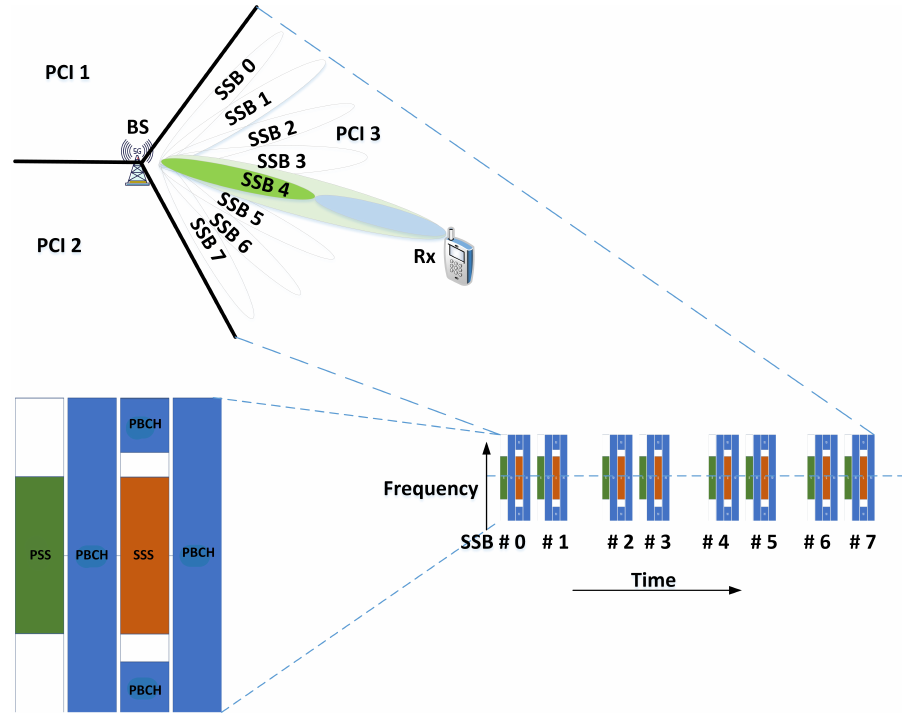
Figure 1. Beam-based transmission with N = 8 beams. Each SS/PBCH Block (SSB) is transmitted on a dedicated